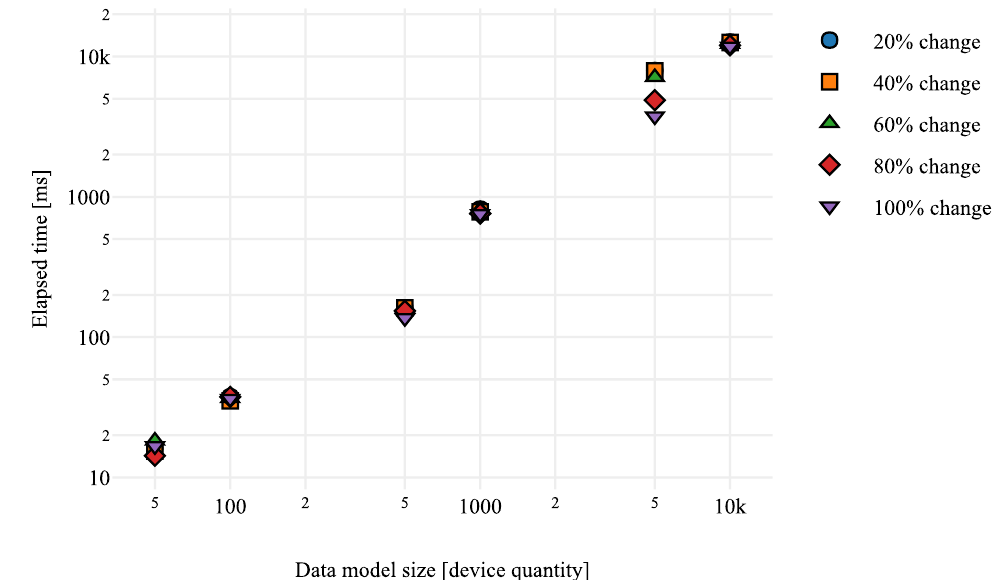
Figure 8. The time need for detection versus ICPS Data Model sizes (the axes are in logarithmic